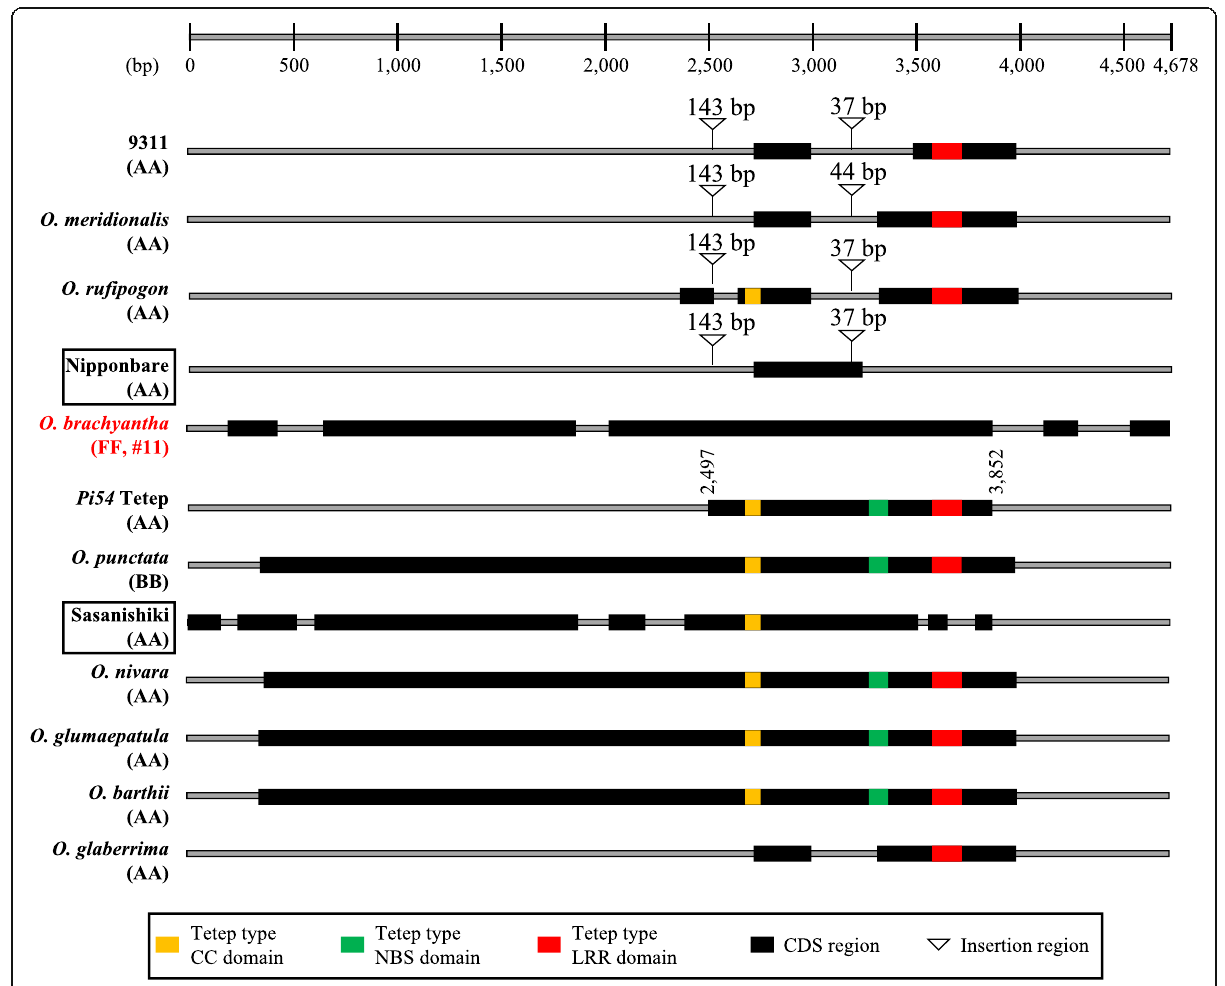
Fig. 6 Schematic representation of DNA sequences of Pi54 alleles. The sequences of Nipponbare, O. rufipogon , O. meridionalis , O. sativa ssp. indica (9311 and Tetep), and O. glaberrima include the gene sequences and 800 bp upstream sequences, while the other 5 sequences are gene sequences only (starting from ATG). CC, coiled coil